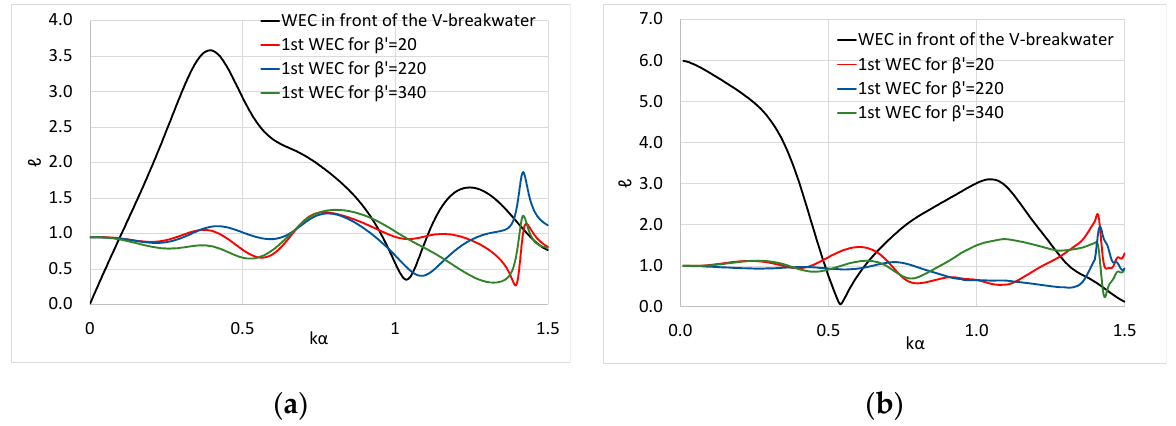
Figure 10. Ratio, ℓ , of the exciting forces for the WEC (wave energy converter) in front of the V-shaped breakwater and for the first WEC (wave energy converter) of a circular array of six converters: ( a ) horizontal-exciting-force ratio; ( b ) vertical-exciting-force ratio.